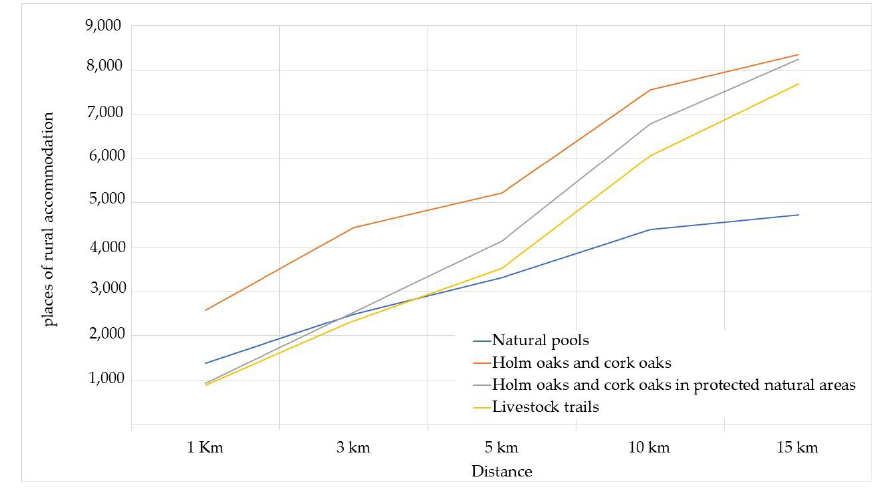
Figure 5. Rural accommodation beds available at multiple distances from tourist attractions.